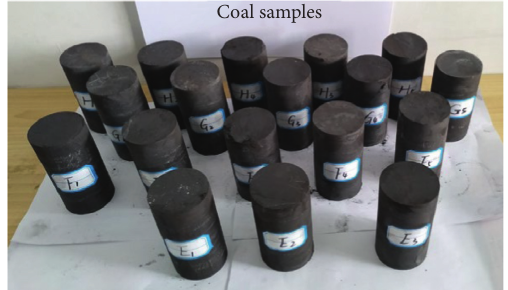
Figure 1: Coal samples.